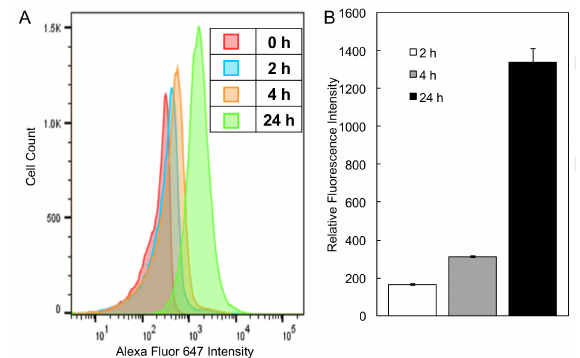
Figure 7. ( A ) Flow cytometry histograms of THP-1 cell uptake of Alexa Fluor 647 labelled micelles by cell population. ( B ) Graph of THP-1 cell uptake of Alexa Fluor 647 labelled micelles by mean fluorescence intensity. Data shown as the mean ± S.D. ( n = 3).